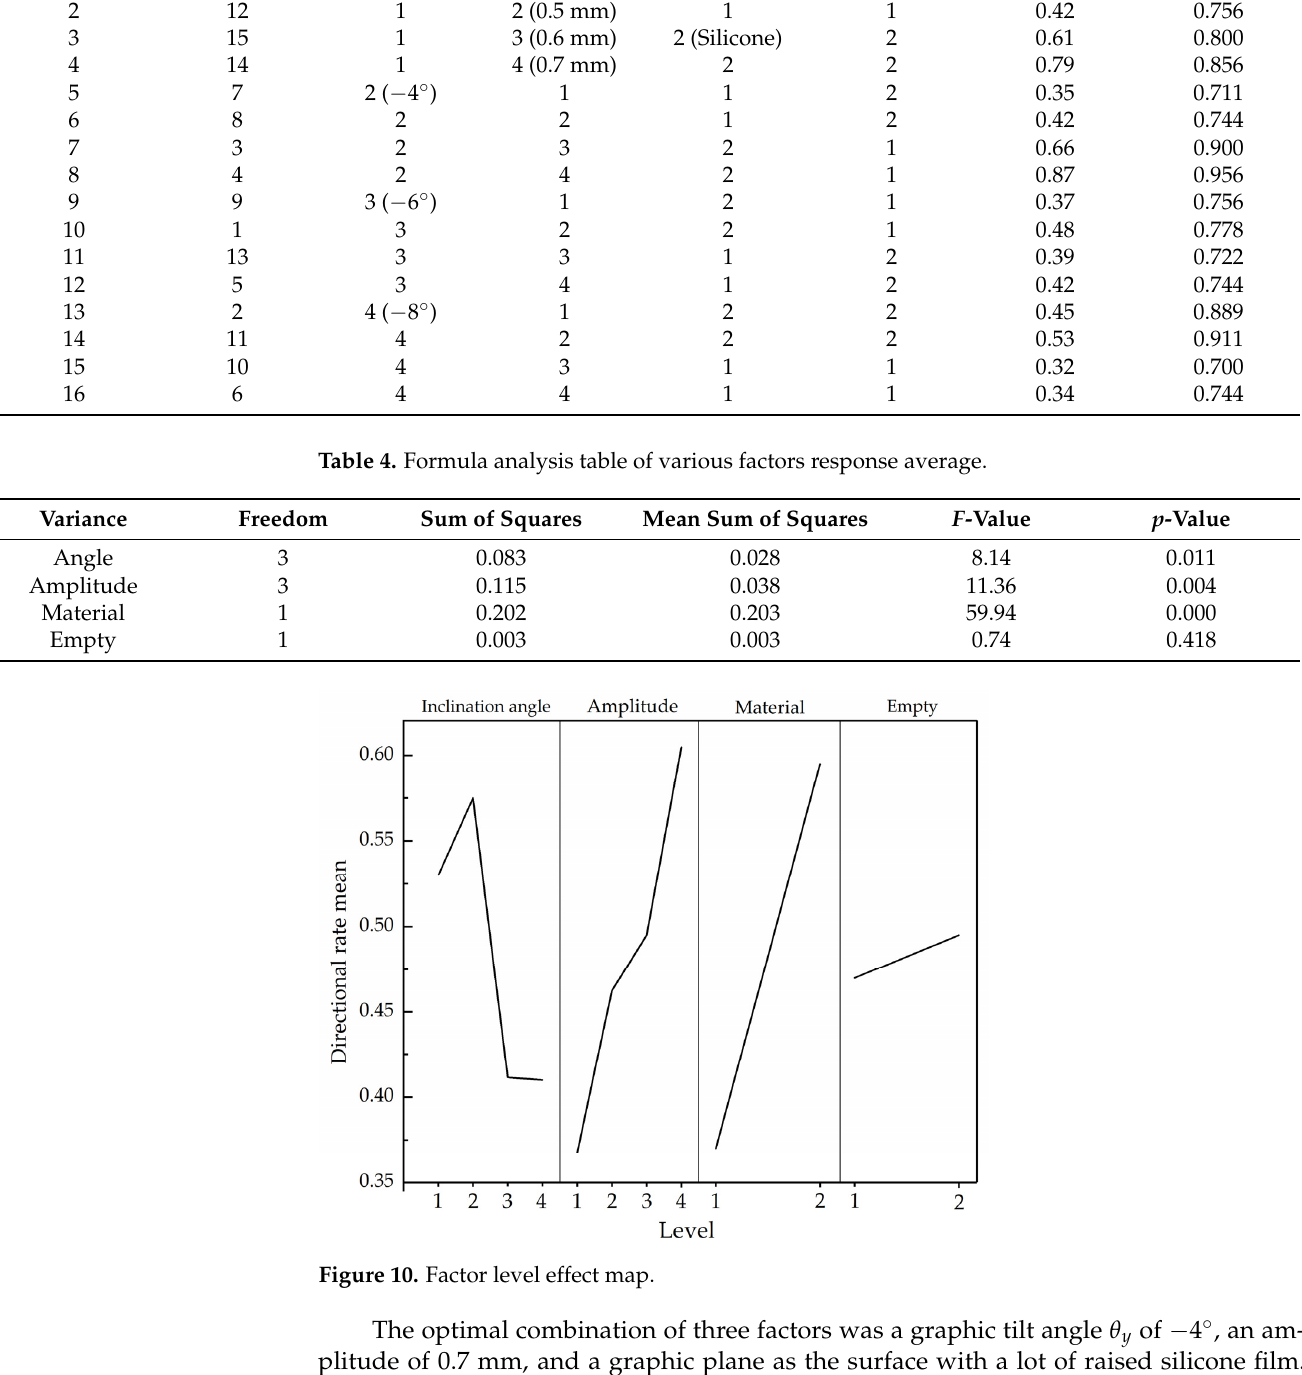
Table 4. Formula analysis table of various factors response average.